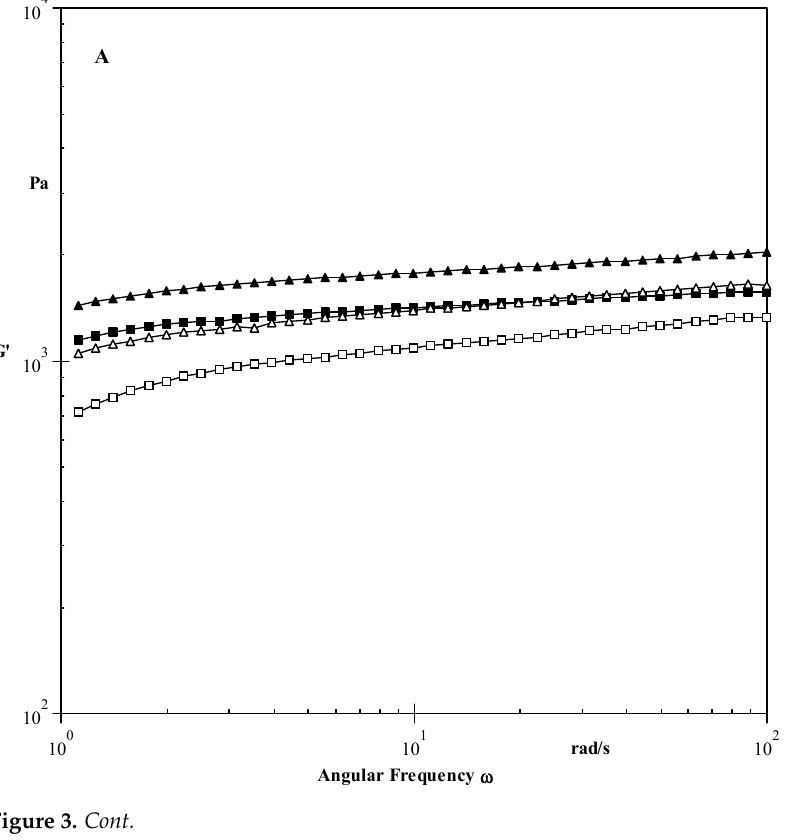
Table 3. Pasting properties of native and modified starches.